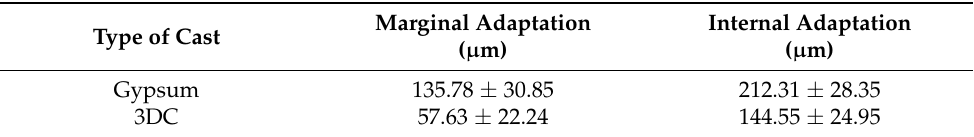
Table 2. Mean marginal and internal interfacial adaptation data ± standard deviation, expressed in µ m for conventional casts and